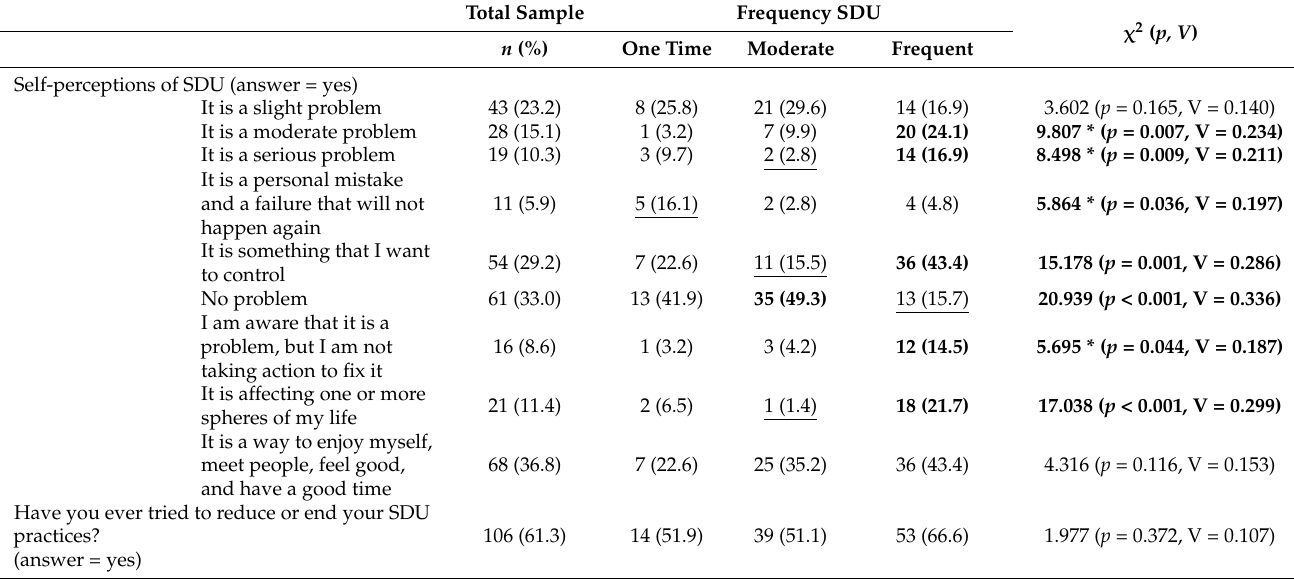
Table 4. Self-Perceptions of